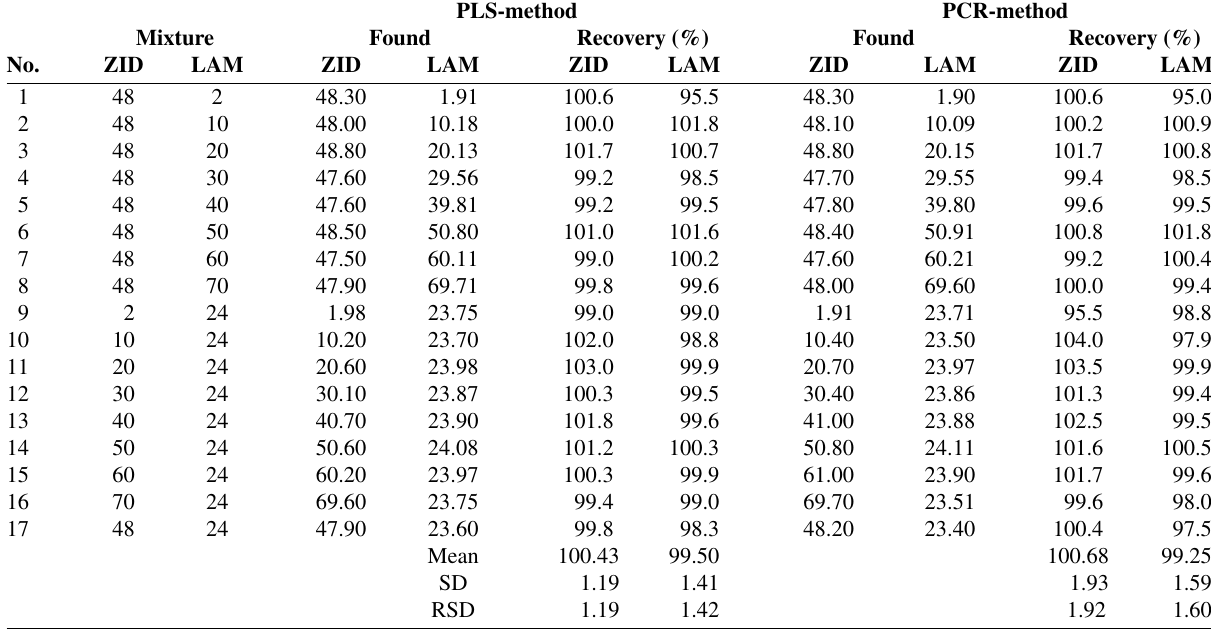
Table 2. Recovery data obtained by applying the PLS and PCR methods to the analysis of ZID and LAM in the synthetic mixtures PLS-method PCR-method